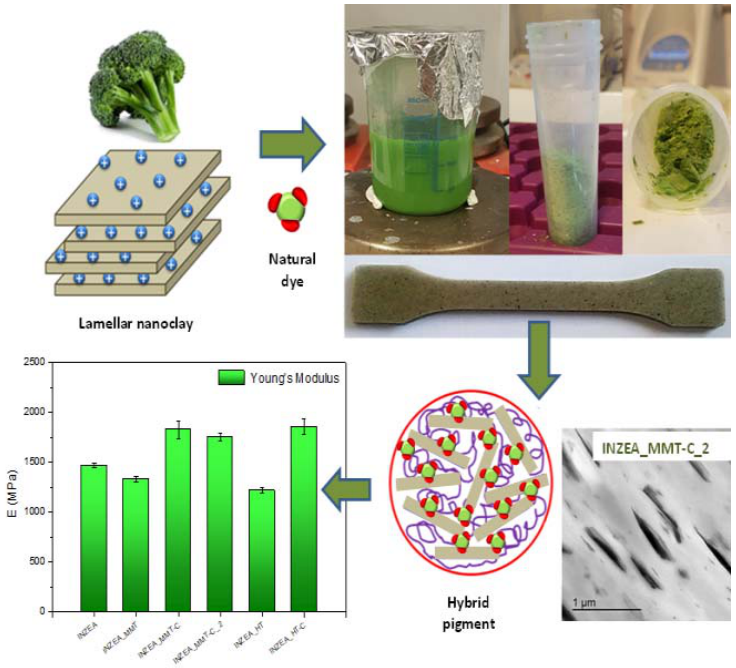
Figure 6. Hybrid nano-pigments extracted from broccoli waste. Reprinted from [21] with permission of MDPI.